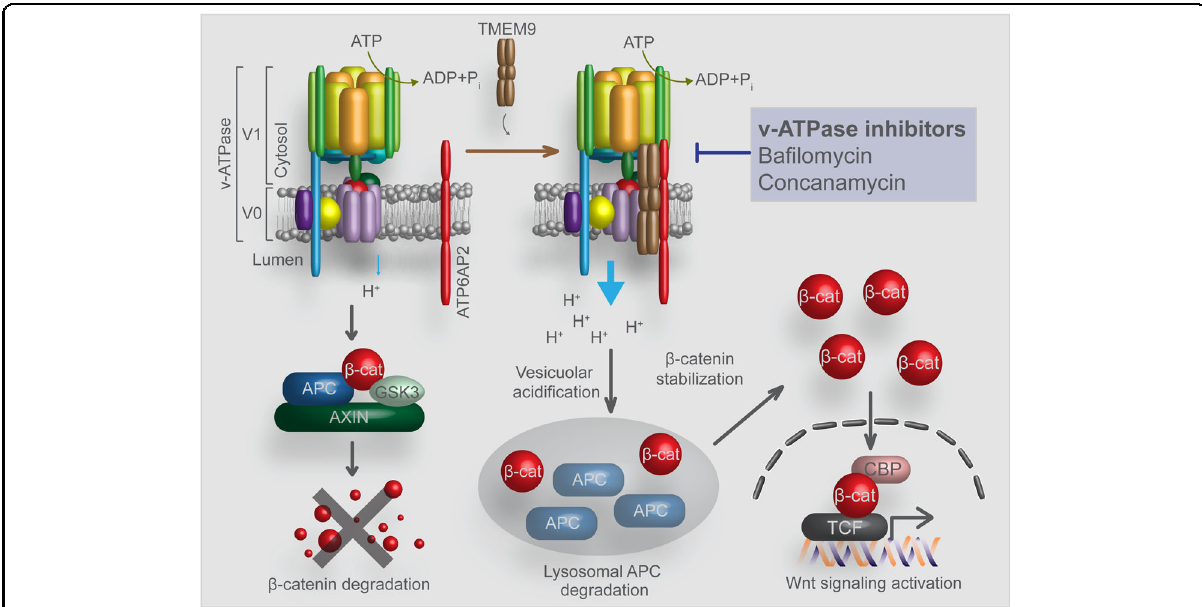
Fig. 2 Inhibition of Wnt/ β -catenin signaling activity by targeting the TMEM9-v-ATPase axis. TMEM9 expression is highly increased in CRC. As an ampli fi er of Wnt/ β -catenin signaling, TMEM9 facilitates the assembly of v-ATPase, resulting in vesicular acidi fi cation and subsequent lysosomal degradation of APC. Then, the increased β -catenin transactivates Wnt target genes. The inhibition of TMEM9-v-ATPase-induced vesicular acidi fi cation by ba fi lomycin and concanamycin ef fi ciently inhibits APC lysosomal degradation, which leads to the suppression of Wnt/ β -catenin gene activation in cancer